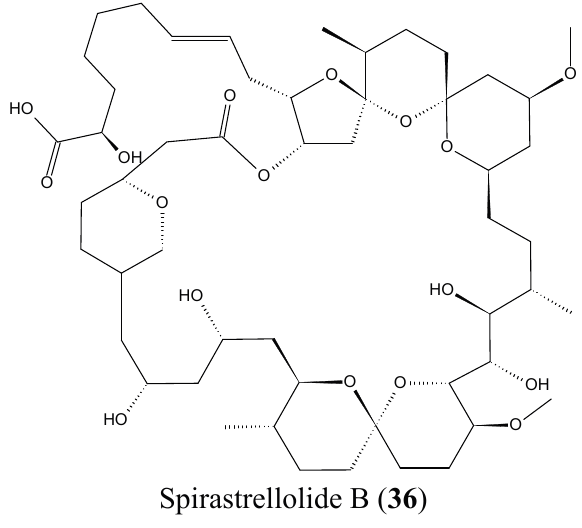
Figure 14. Spirastrellolides A and B.